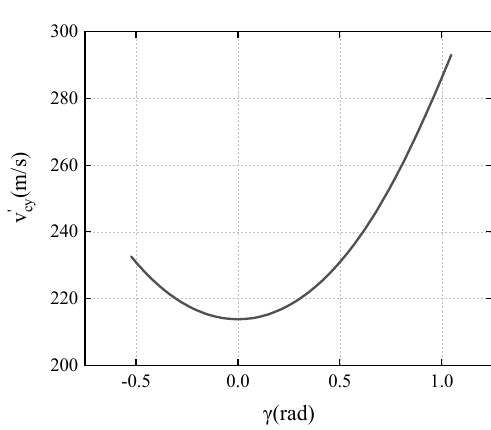
Figure 16. The variation of v (cid:48) cy with γ .